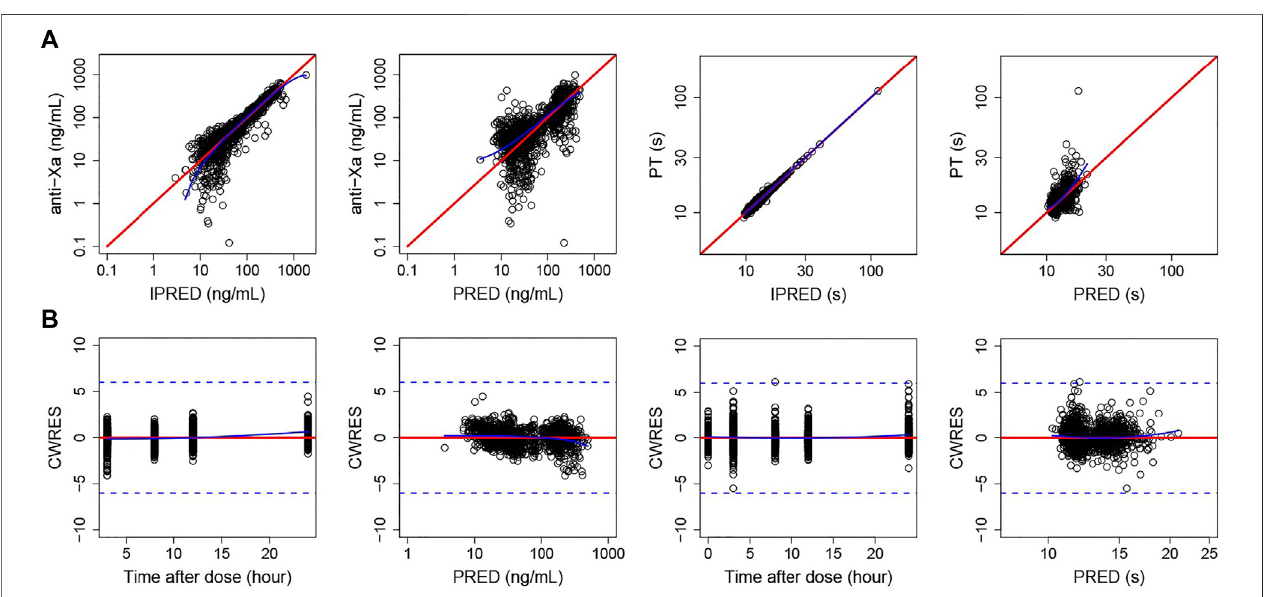
FIGURE 1 | GOF plots for the integrated PK/PD model. A : anti-Xa, B : PT.